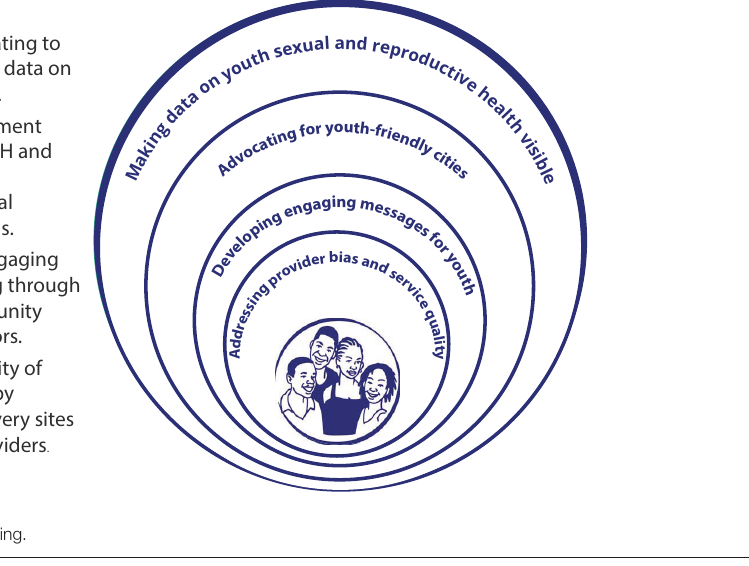
FIGURE 2 | TCI’s concentric circle strategy for AYSRH programming.